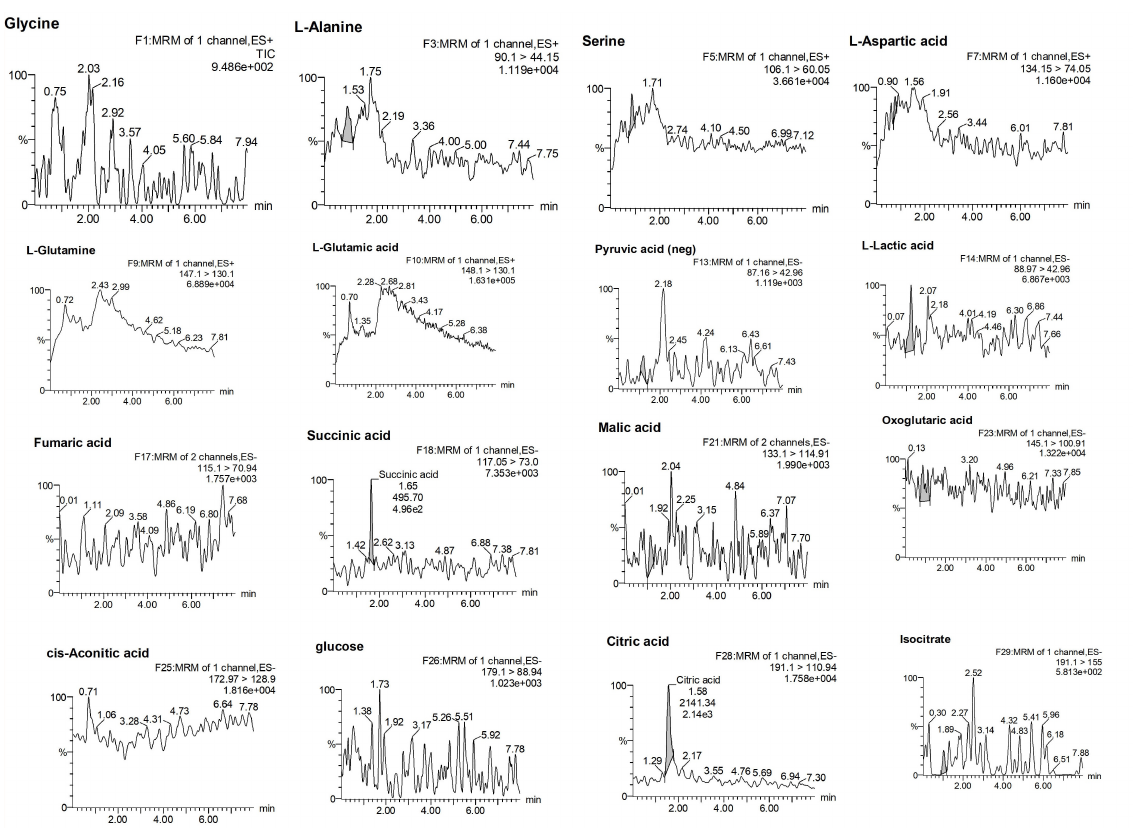
Figure 1. Blank chromatogram of tricarboxylic acid (TCA) cycle intermediate.